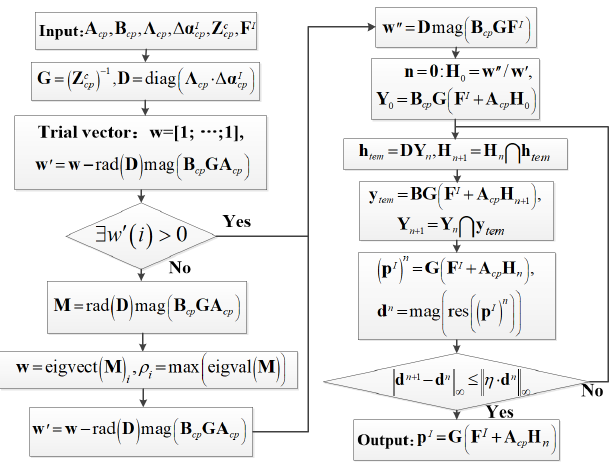
Figure 6. Flow chart of Neumaier–Pownuk